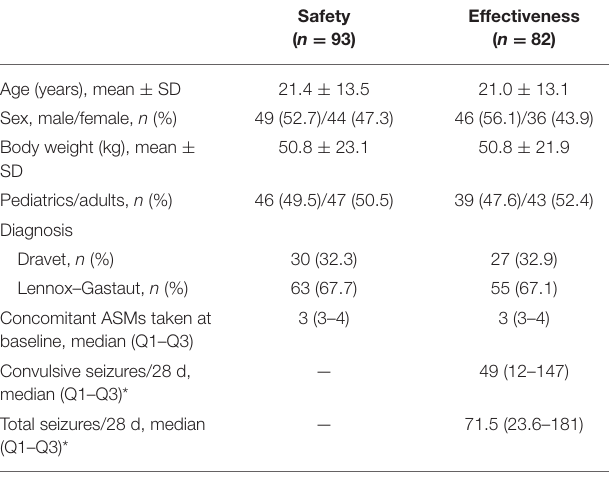
TABLE 1 | Patients baseline demographic and clinical